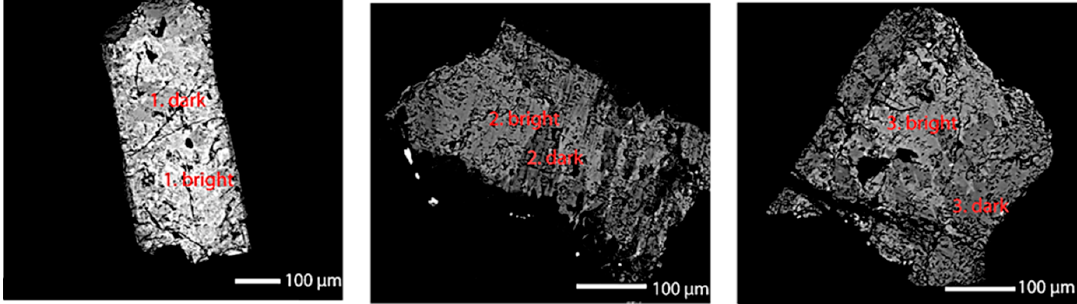
Figure 3. Various textural forms of allanite crystals from samples of heavy mineral sands from Kavala (modified from Tzifas et al. [33]).